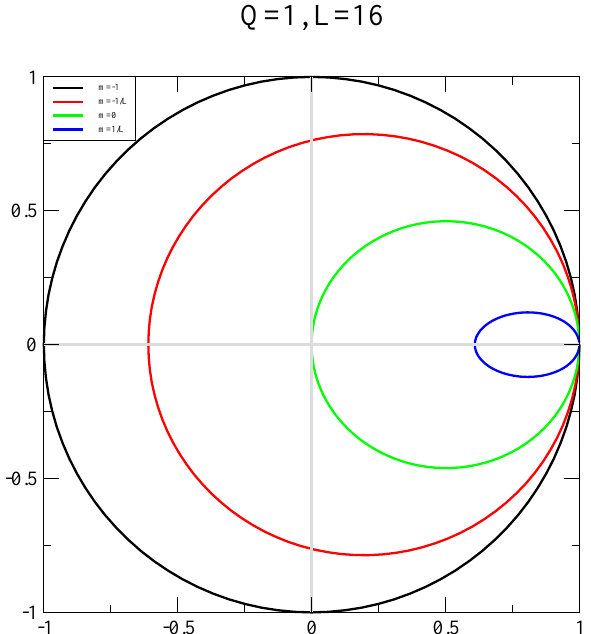
Figure 2. The flow of the overlap fermion determinant in the complex plane as a function of h 3 at a fixed Q = 1 on L = 16 lattice. The flows are shown for m = (blue). The flow starts at ( 1,0 ) for h 3 = 0, goes clockwise and returns back to ( 1,0 ) for h 3 = 1.